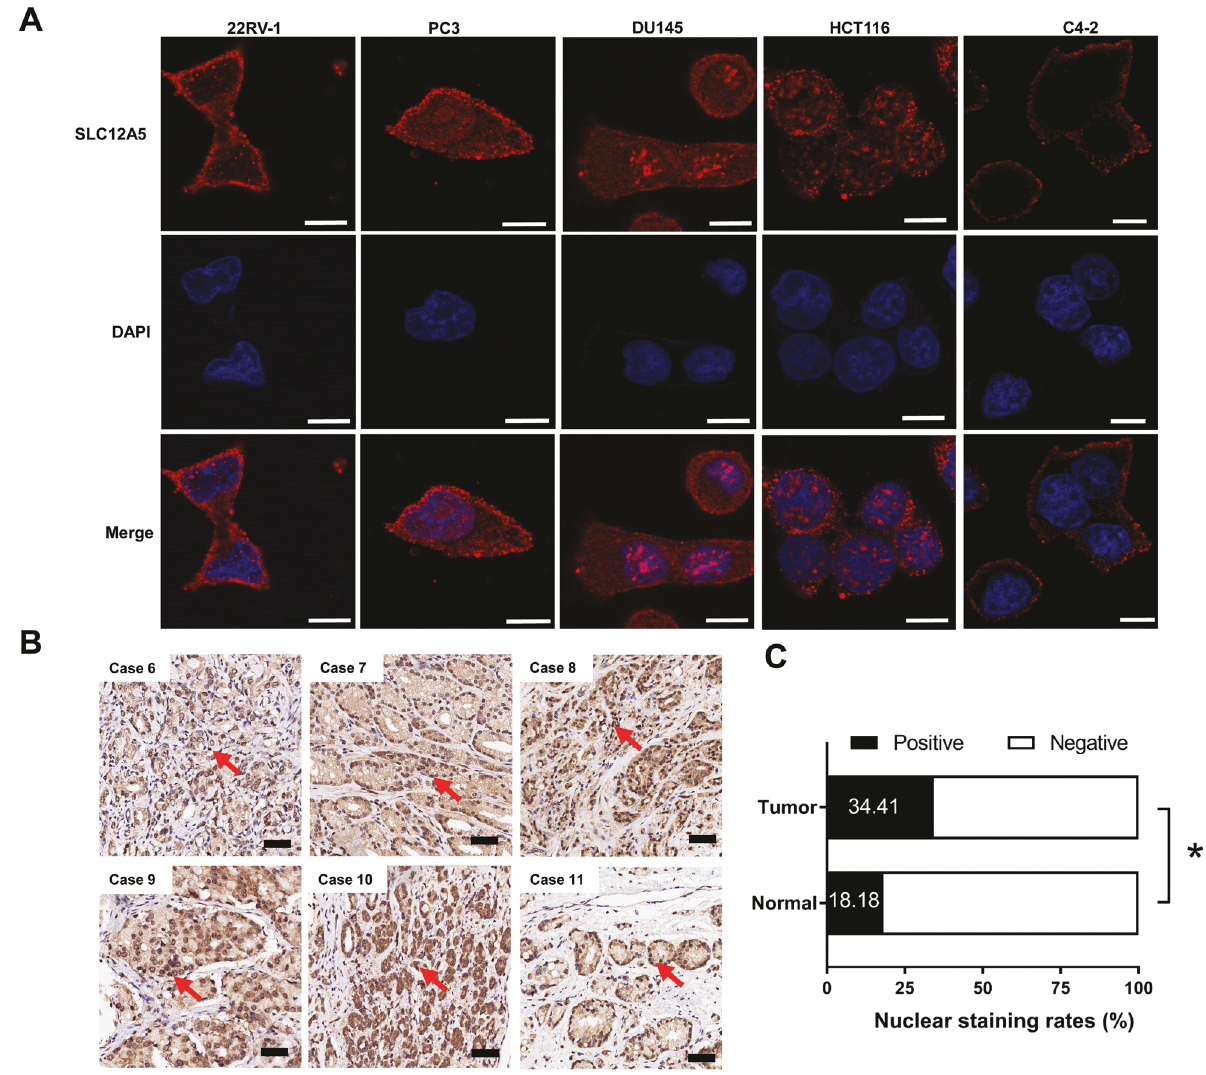
Fig. 4 SLC12A5 protein can be detected in the cell nucleus. A Immuno fl uorescence staining was performed to clarify the localization of SLC12A5 protein in SLC12A5 highly expressing prostate cancer cells (22RV-1, PC3 and DU145). Colorectal cancer HCT116 cell line was used as a positive control for nuclear localization and C4-2 cell line was used as a negative control for nuclear localization. Scale bars represent 10 μ m. B Immunohistochemical staining of prostate cancer tumor tissues (Case 6-Case 11) showed SLC12A5 protein was partly localized in the nucleus. Scale bars represent 50 μ m. C The positive nuclear staining rates of SLC12A5 protein were compared using χ 2 (chi-square) test. * P <